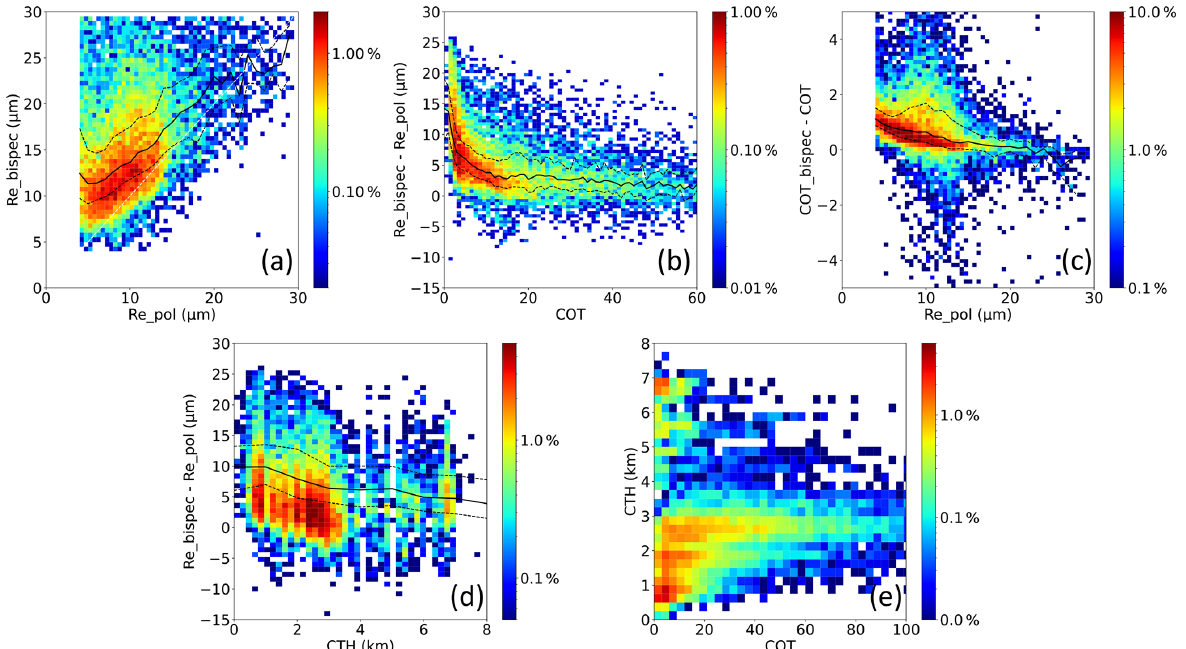
Figure 3. RSP 2-D density histogram of (a) polarimetric R e vs. bi-spectral R e , (b) RSP COT vs. R e difference (bi-spectral R e – polarimetric R e ), (c) polarimetric R e vs. COT difference (bi-spectral – cloud bow), (d) CTH vs. R e difference (bi-spectral R e – polarimetric R e ), and (e) RSP COT vs. CTH. The black solid lines in panels (a) – (d) plot the median with respect to each horizontal bin, and black dashed lines indicate the interquartile